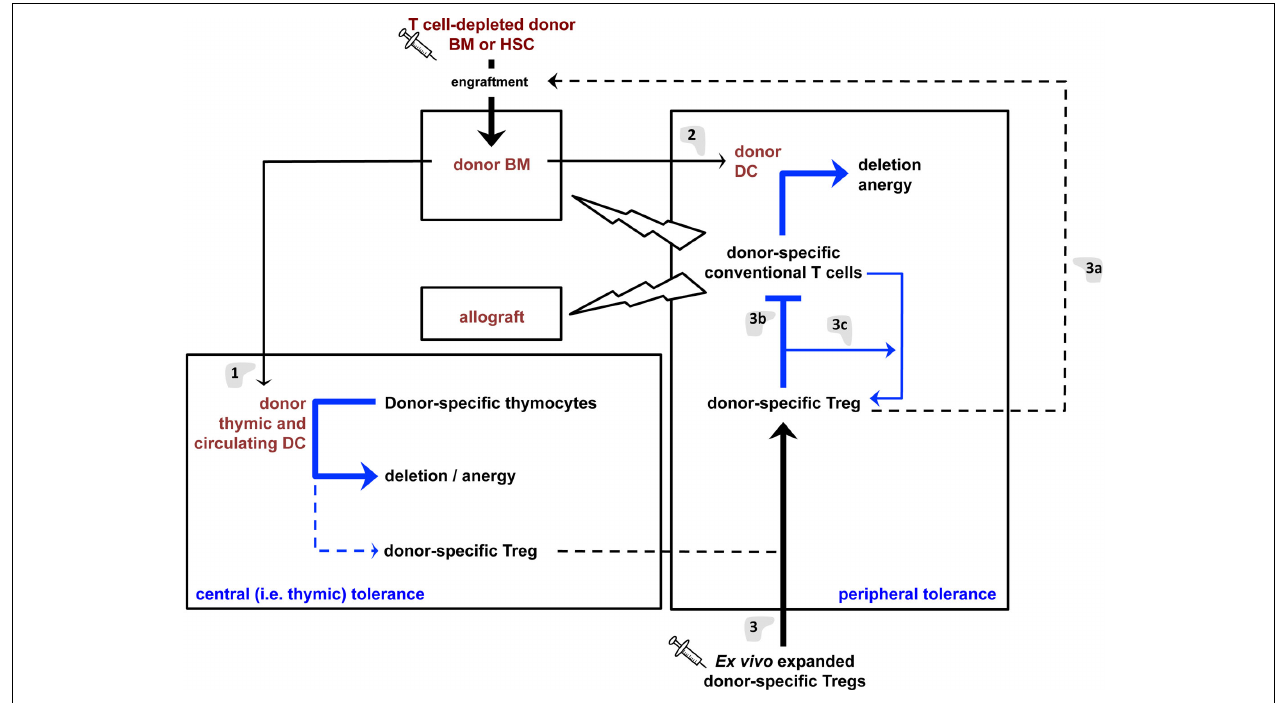
cells may, to a limited extent, directly induce donor-specificTreg. However, the dominant tolerance (i.e.,Treg) induce by hematopoietic chimerism in (1) and (2) appears insufficient to durably prevent most notably chronic allograft rejection. (3) Infusion of donor-specificTreg will aid in engraftment of grafted donor BM/HSC (a) and inhibit the reactivity of mature peripheral donor-specificT lymphocytes (b), thus favoring graft-acceptance. They will also allow the differentiation of donor-specific conventionalT lymphocytes intoTreg (c), thus assuring persistence of tolerance and preventing chronic allograft